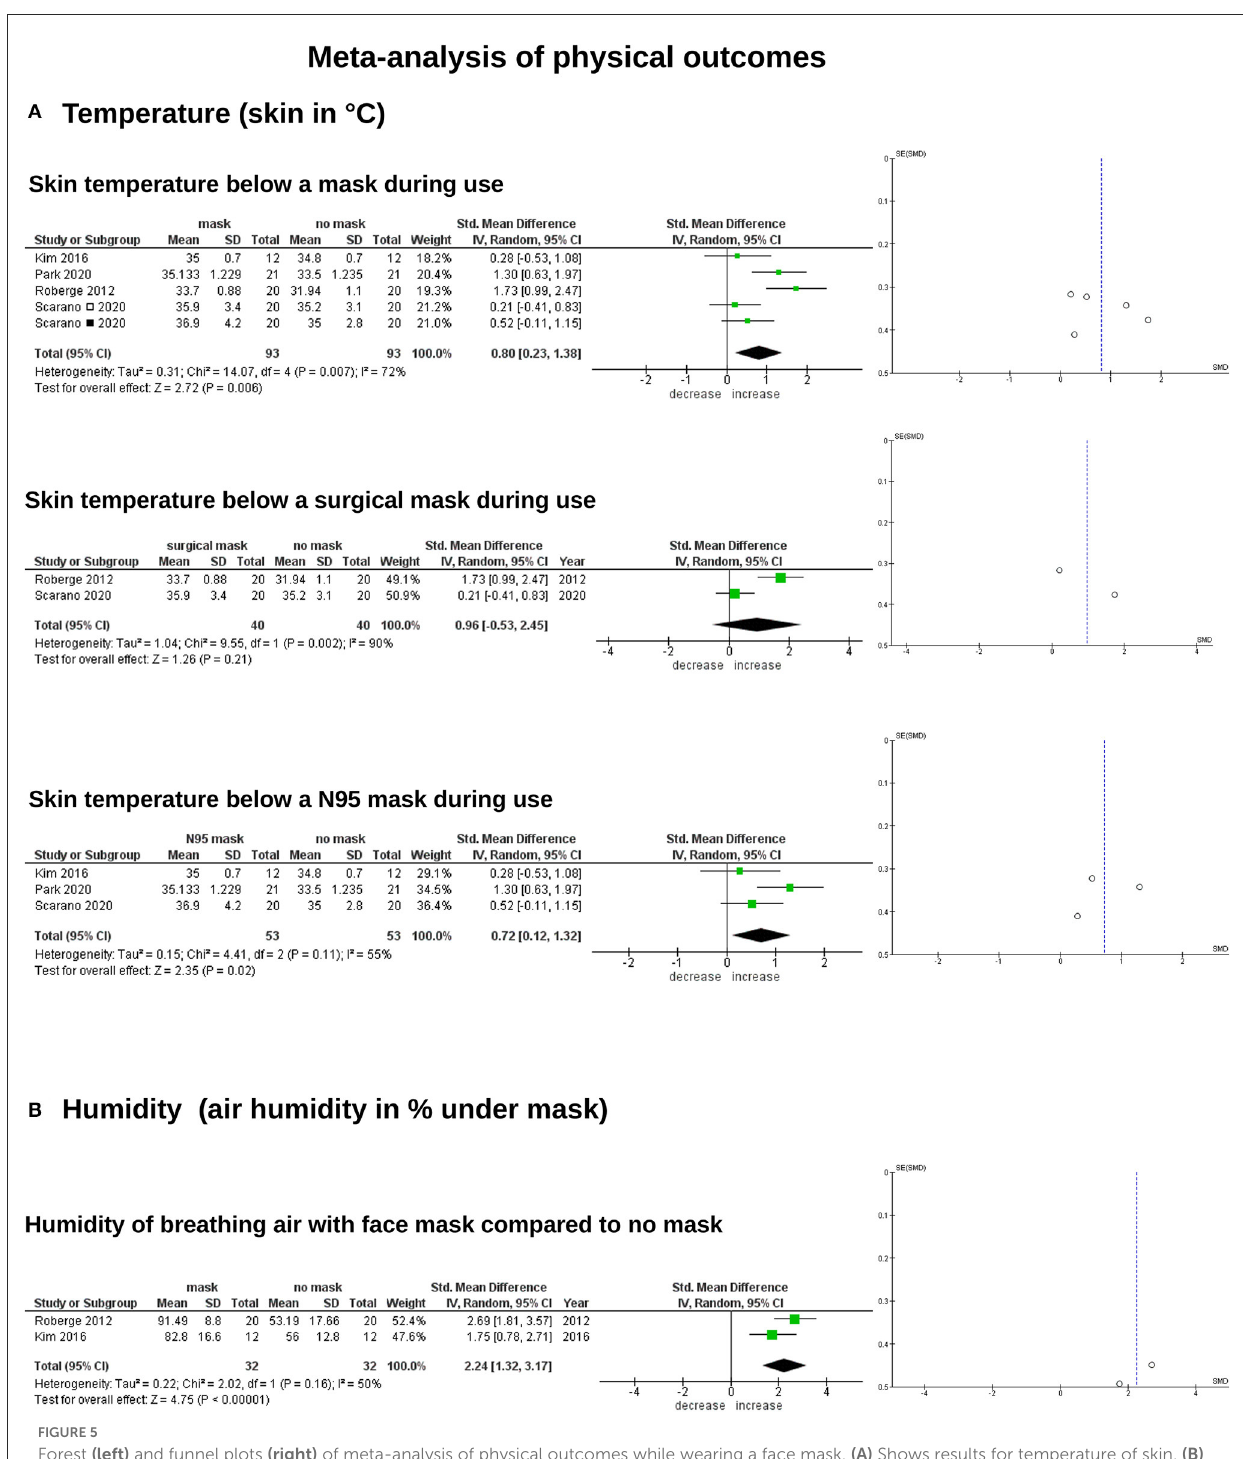
surgical mask (cid:4) N95 mask. (A) Skin covered by mask has = =